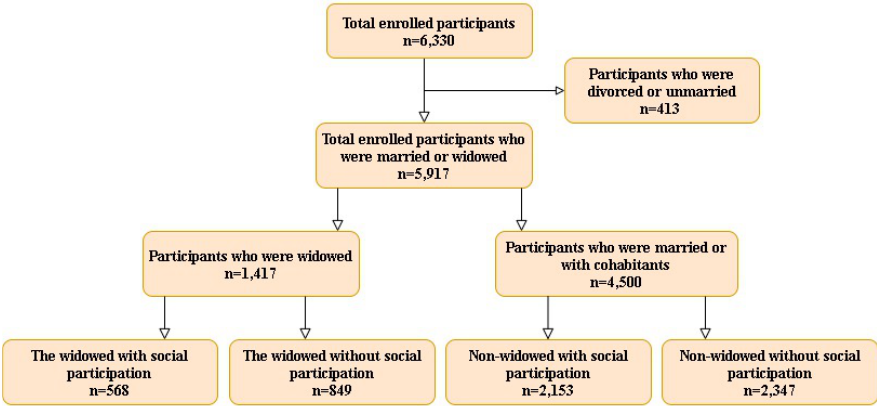
Figure 1. A flow diagram of the subject-inclusion process.